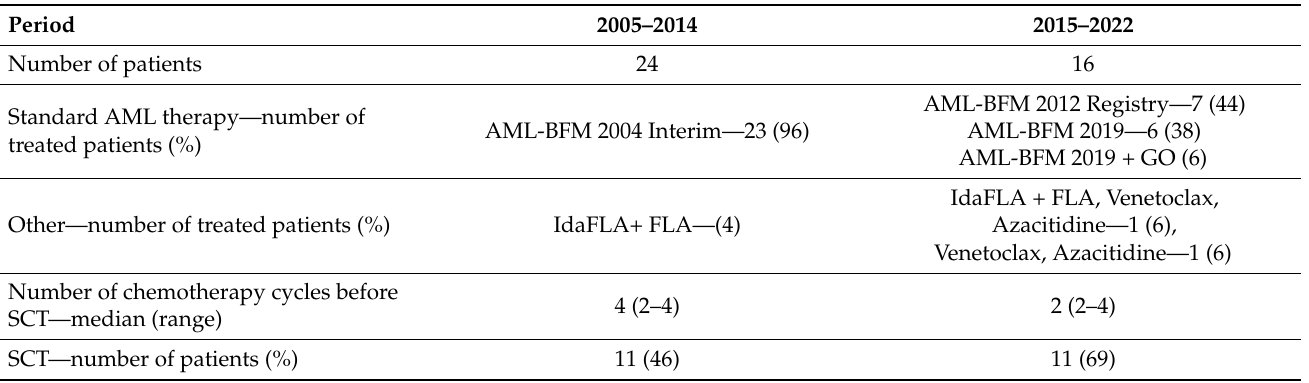
Table 5. Treatment of acute myeloid leukemia post cytotoxic therapy in the two periods.